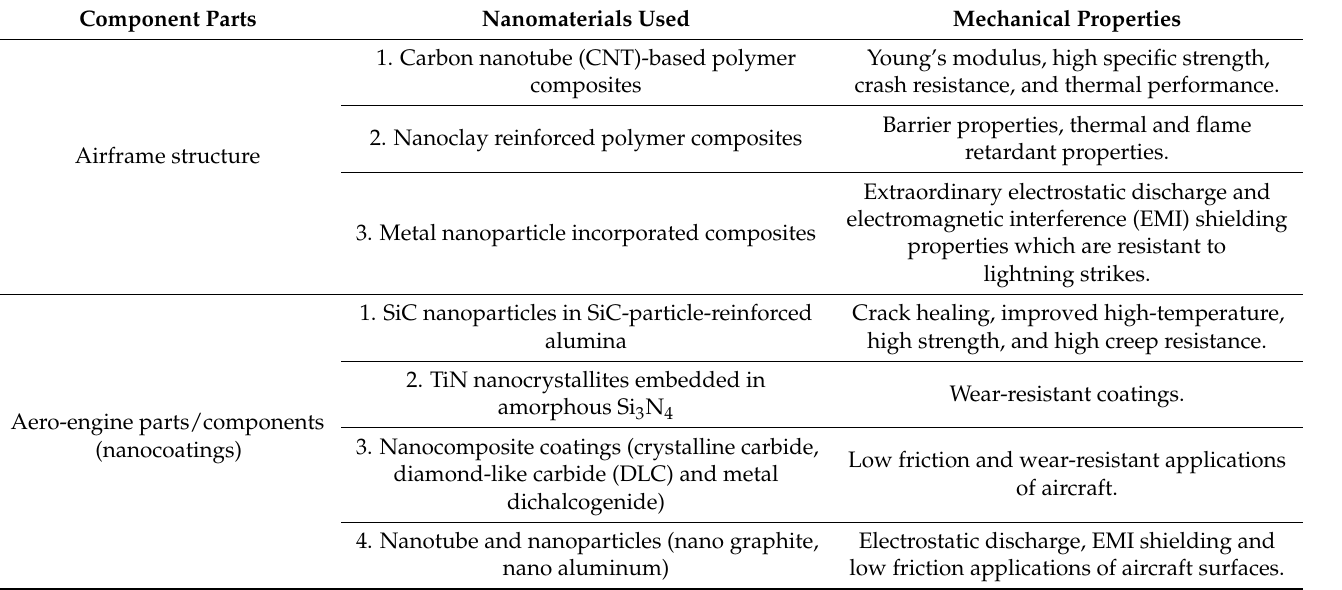
Table 1. Most ENMs used in components related to airframe structure, aero-engine parts, and aircraft electro-communication